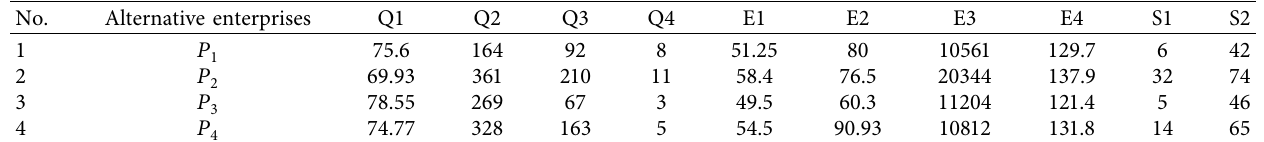
Table 3: Initial evaluation indicators of each alternative